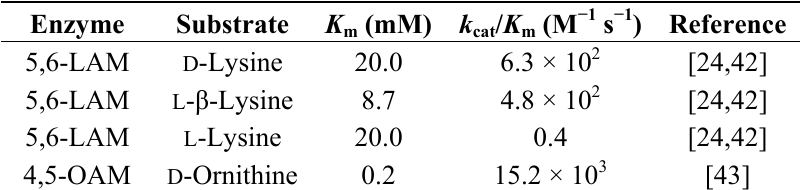
Table 1. Steady-state kinetic